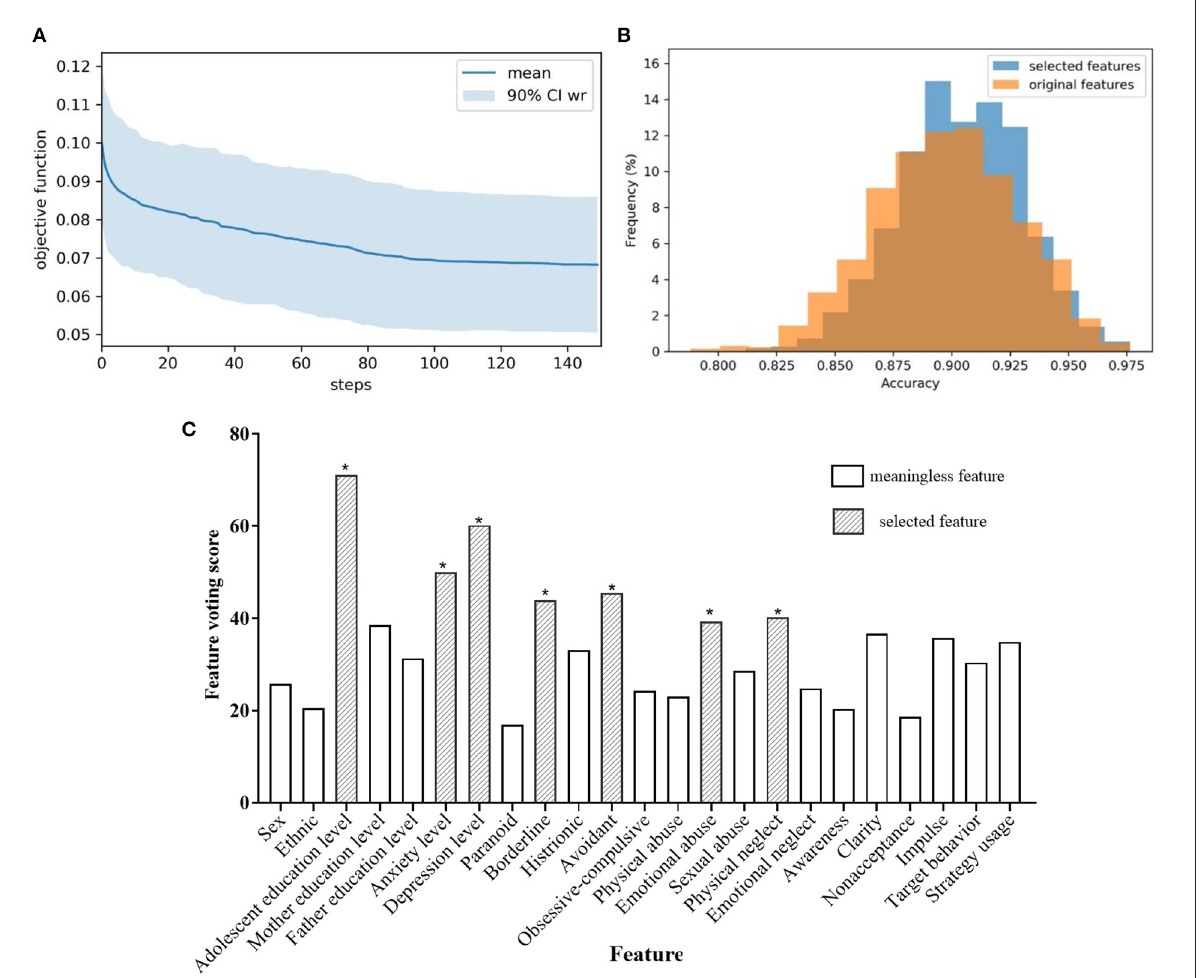
FIGURE4 (A) Objective function of the training process for identifying mood disorders; (B) The distribution of classification accuracy for identifying mood disorders; (C) Feature voting for identifying mood disorders; *selected